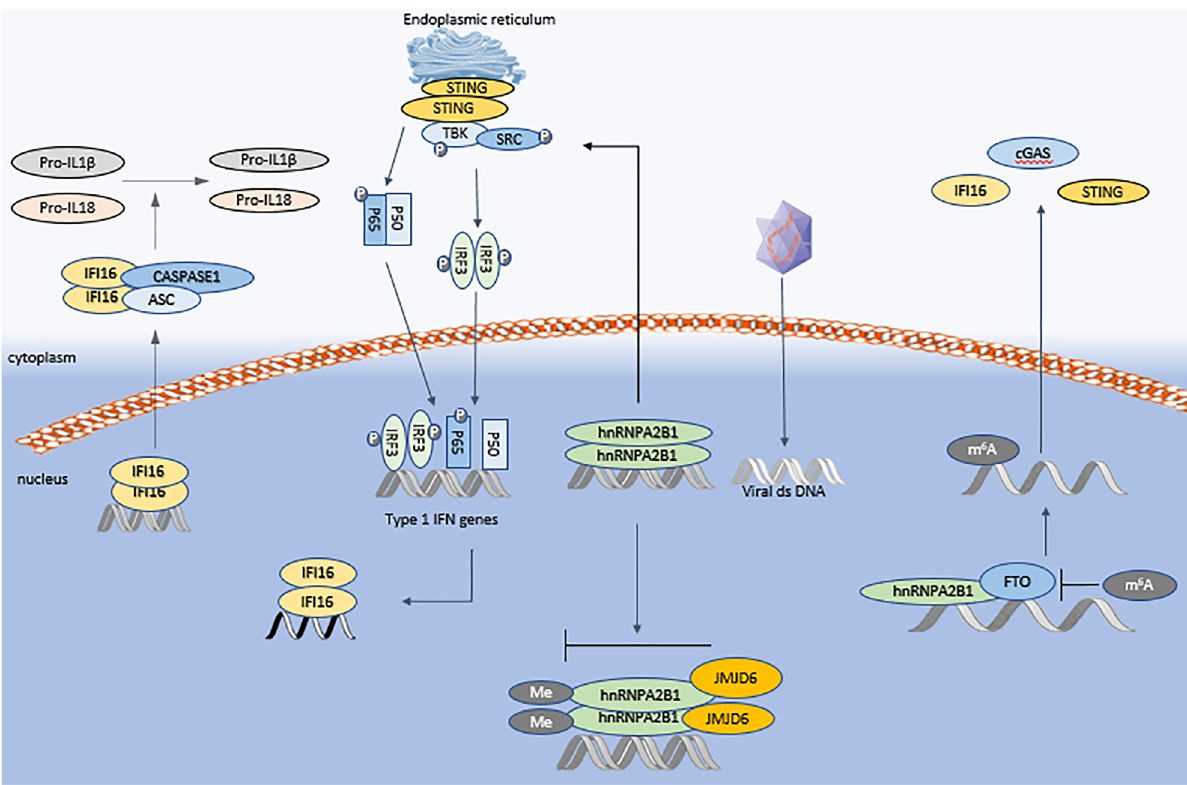
Figure 2: IFI16 and hnRNPA2B1 act as nuclear DNA sensors in inflammation and innate immunity. During HSV-1 infection, genomic viral DNA of HSV-1 is translocated into the nucleus. The JMJD6, arginine demethylase, is activated via homo- oligomerization. Subsequently, dimer induces the demethylation of hnRNPA2B1 dimer at Arg 226 , leading to the translocation of hnRNPA2B from the nucleus to the cytoplasm. hnRNPA2B1 is triggered to STING and Src and induces IFN-Is expression through TBK1-IRF3 signaling. Furthermore, in resting cells, methylated hnRNPA2B1 recruits FTO to IFI16 , STING, and CGAS mRNA. FTO facilitates the demethylation of these mRNAs and restricts them in the nucleus. Upon HSV-1, demethylated hnRNPA2B1 disassociates with FTO and releases CGAS , IFI16, and STING mRNAs. The methylated mRNAs are translocated to the cytoplasm and increase the protein levels of STING, cGAS, and IFI16 to amplify the cytoplasmic innate immune signaling. After identifying the HSV-1 dsDNA, nuclear IFI16 initiates the innate immune response against pathogenic invasion through two main mechanisms: (a) IFI16-dsDNA complex is translocated from the nucleus to the cytoplasm to